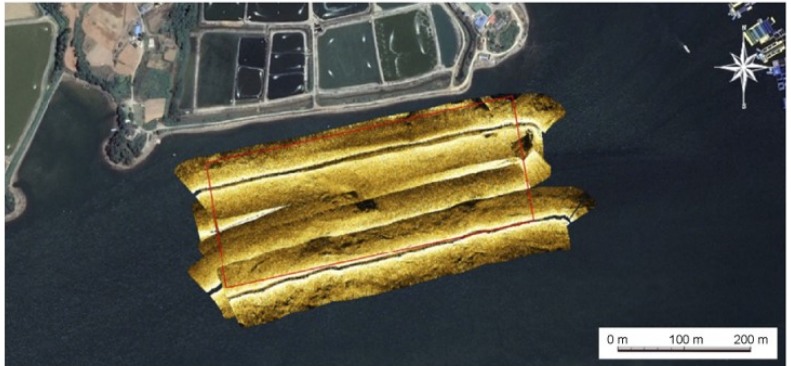
Figure 3. Surveying range of the side scan sonar system at the site ( (cid:3) : the site, Google Earth).